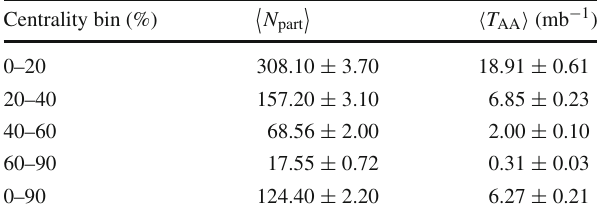
Table 1 Average number of participating nucleons overlap function (cid:4) T AA (cid:5) for each centrality class [40] Centrality bin